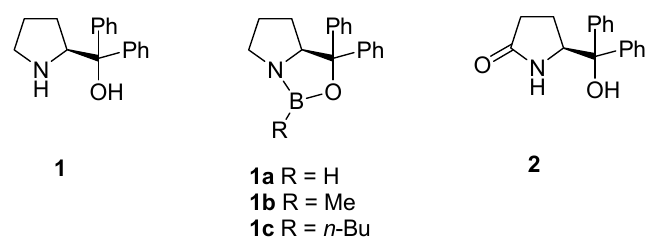
Figure 1. Various chiral catalysts and precatalysts.